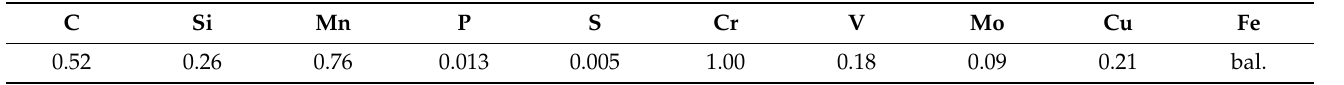
Table 1. Chemical composition of the studied 51CrV4 spring steel (wt.